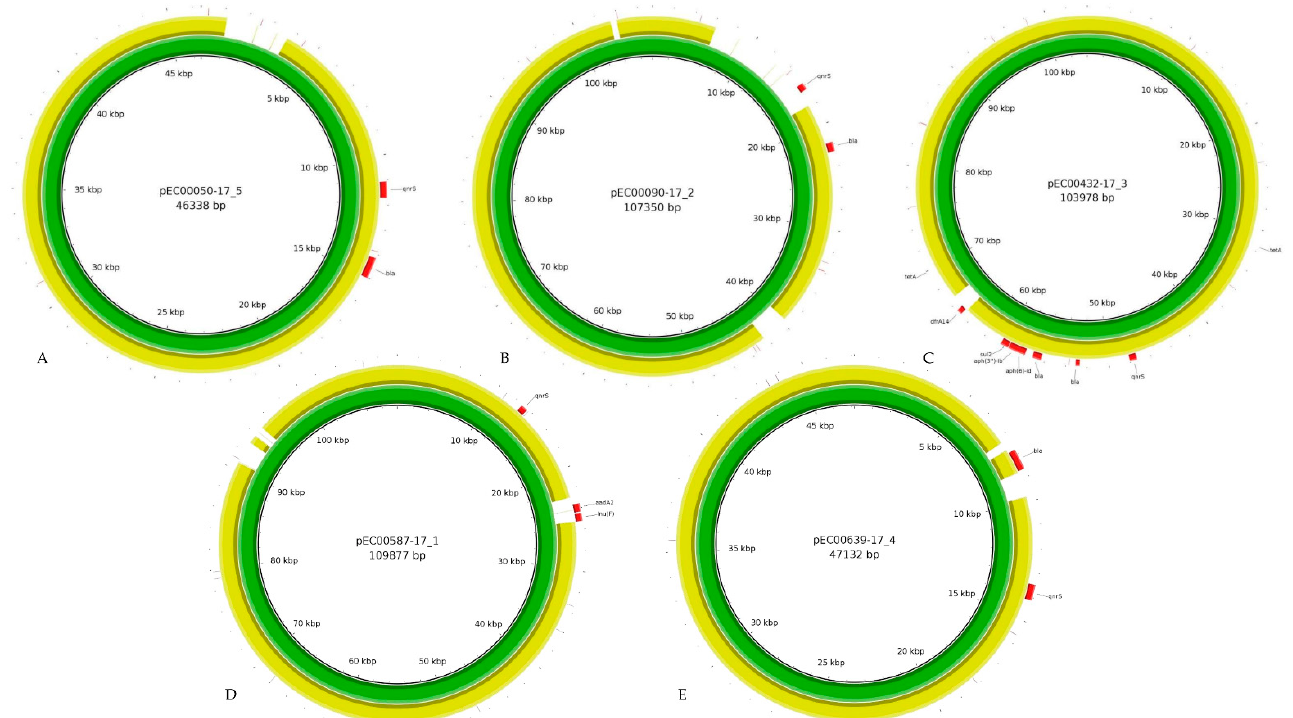
Figure 2. Plasmid composition of extrachromosomal elements carrying the qnrS1 gene. A : 17-AB00050 B : 17-AB00090 C : 17-AB00432 D : 17-AB00587 E : 17-AB00639. Illustrations were generated from hybrid assembly with BRIG (v0.95). Red elements represent the resistance genes. Green colored rings represent the isolates plasmid. Yellow colored rings represent the reference plasmid (annotation of plasmids are available in Supplement 6).